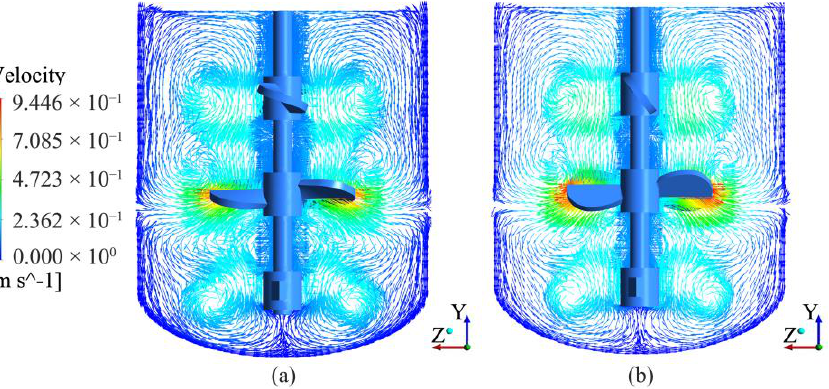
Figure 12. Velocity vector diagram when the medium in YZ section is glycerin and Re = 55.5. ( a ) TBC-A type agitator, Plane 2:YZ,X = 0 mm; ( b ) TBC-B type agitator, Plane 2: YZ,X = 0 mm.